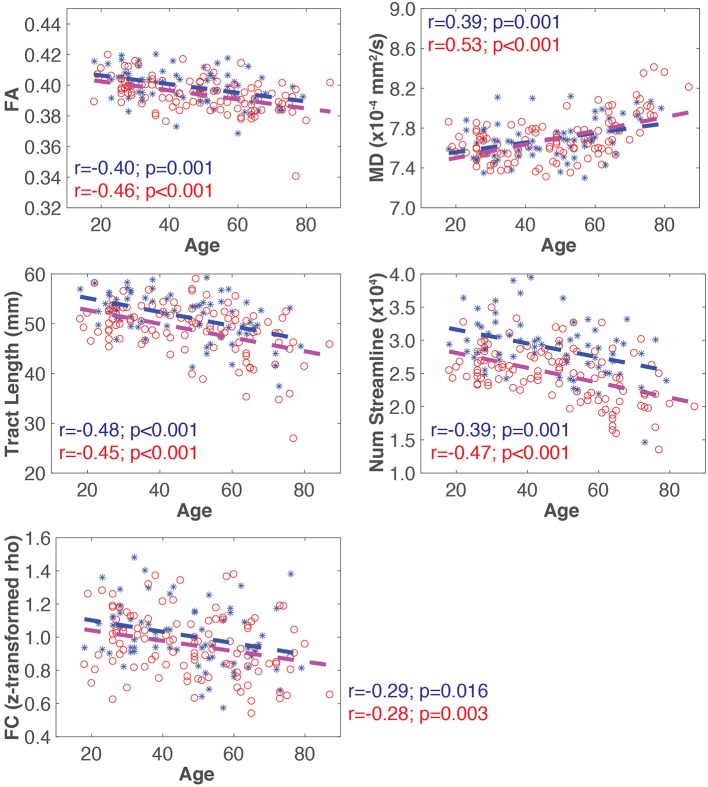
Representative plots of SC and FC measures for all subjects (blue asterisk, male; red circle, female) for the ventral attention network. The blue and red dash lines in each plot represent the linear trajectory to model the change of SC and FC measures with age for all male and female subjects, respectively. The Pearson correlation coefficient (r), and the corresponding uncorrected p-value, for each connectivity measure with age by sex is also shown.